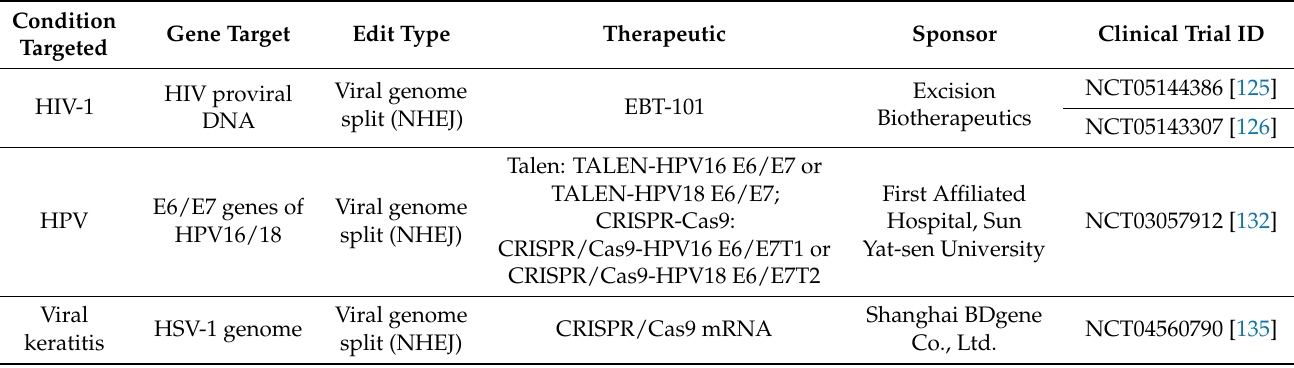
Table 4. List of CRISPR-Cas-based gene editing therapies for infectious